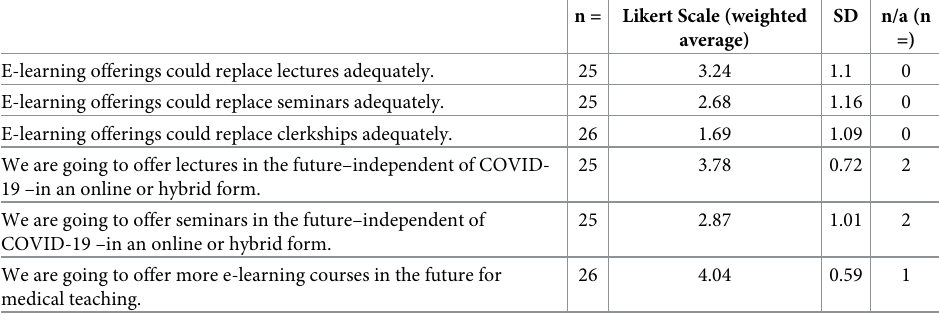
Table 5. Future e-learning prospects in OB/GYN at German university hospitals.